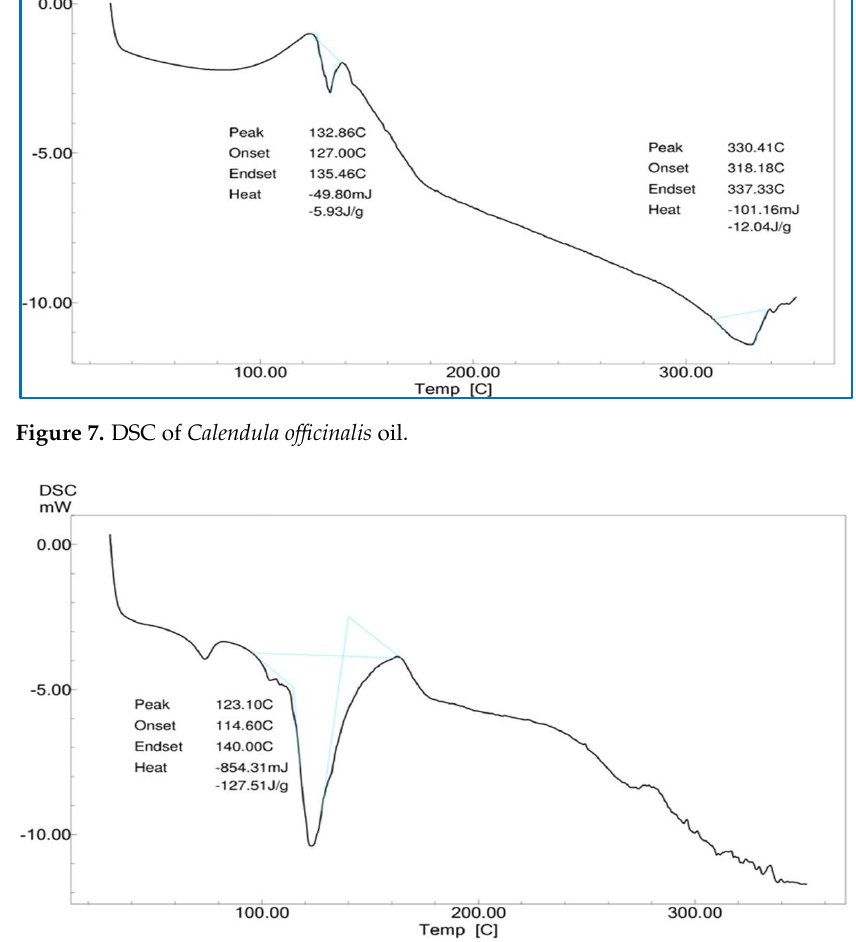
Figure 8. DSC of Calendula officinalis oil-loaded gelatin sponge.